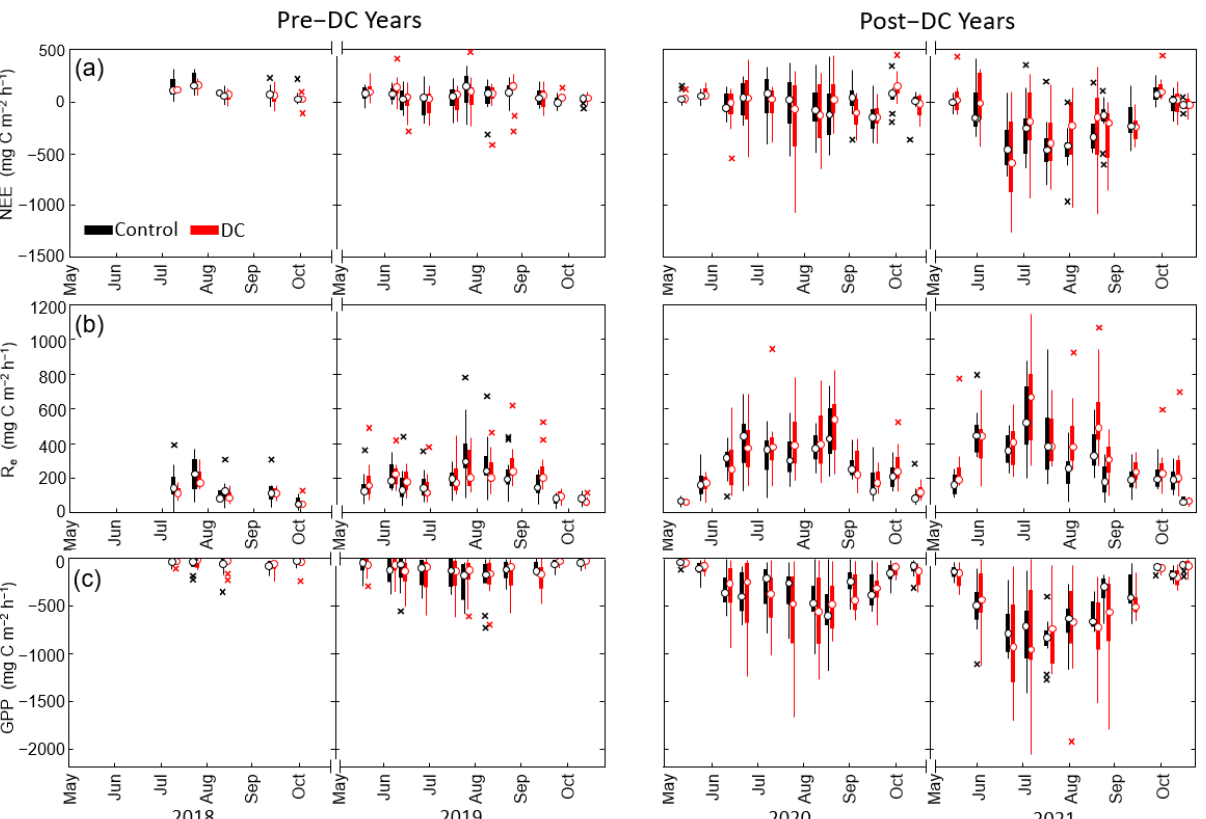
Figure 5. Seasonal variations of carbon dioxide (CO 2 ) flux components including ( a ) net ecosystem exchange (NEE), ( b ) ecosystem respiration ( Reco ) and ( c ) gross primary productivity (GPP) in control and ditch-cleaned (DC) clear-cut areas during pre-DC (2018/19) and post-DC periods (2020/21). Positive and negative values represent losses and uptakes by the ecosystem, respectively. The circles denote sample ( n = 12) medians, whilst the bottom and top edges of the thick bar indicate the 25th and 75th percentiles. The vertical line denotes the range excluding outliers (crosses), which are defined as the values more than 1.5 interquartile range away from the top or bottom of the line. Data shown represent the means of measurement plots at all distances from ditches.